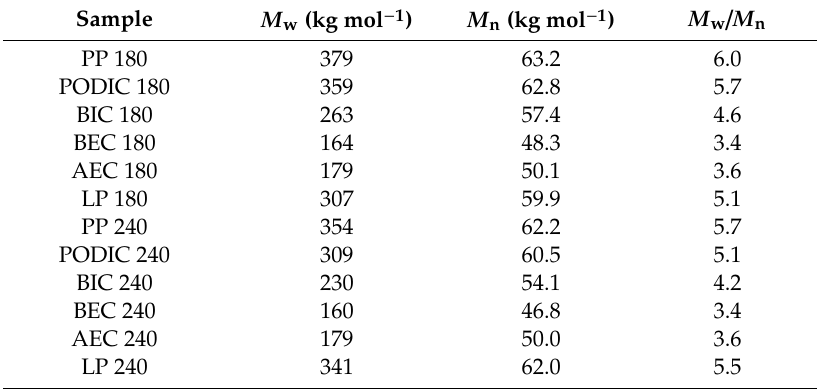
Figure 7. MMD of virgin PP as well as unmodified and modified PP samples at ( a ) 180 °C and ( b ) 240 °C. Table 4. Summary of the GPC data; molar mass and polydispersity of all extruded samples at 180 ◦ C or 240 ◦